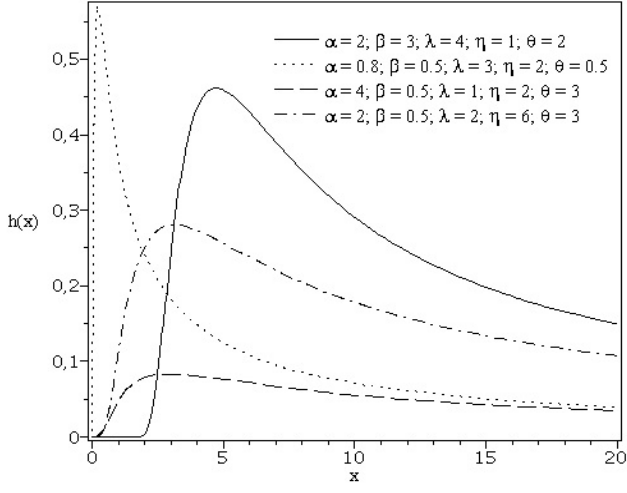
Fig. 2. The hazard function of the EKIW distribution for different values of the